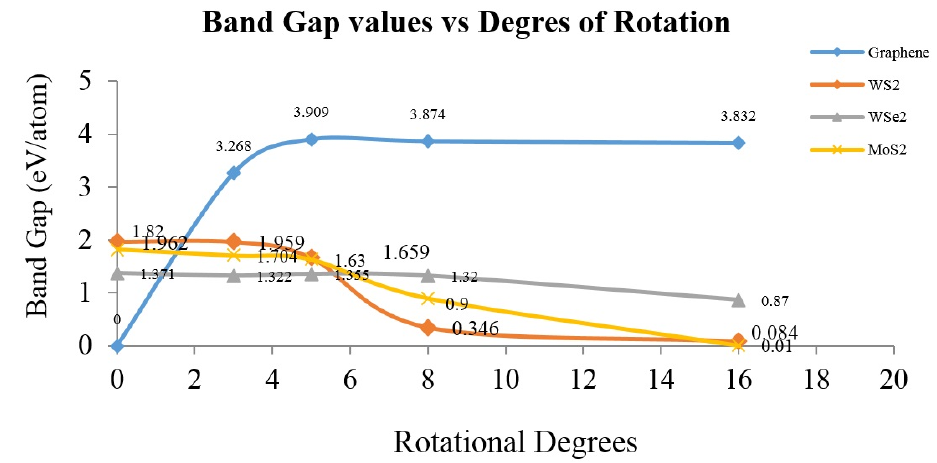
Figure 9. Band gap values of layered molecular models corresponding to graphene, WS 2 , WSe 2 and MoS 2 , as obtained from DFT numerical simulations using CASTEP algorithm.